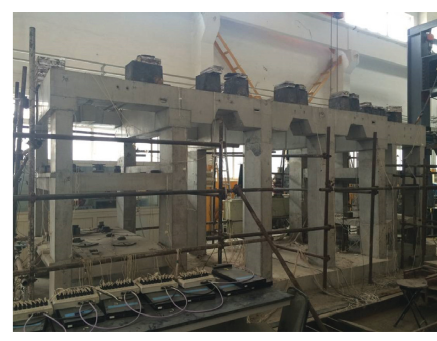
Figure 2: Test site and model. Figure 3: Test setup (transverse load